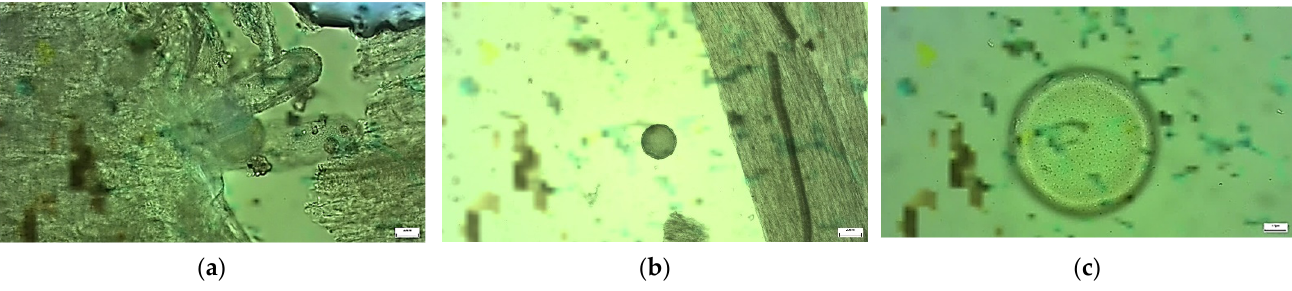
Figure 9. Epidermal cells with elongate papillae on edge of wall 100× ( a ); stigma structure and pollen grain 100× ( b ); pollen grain 400× ( c ).